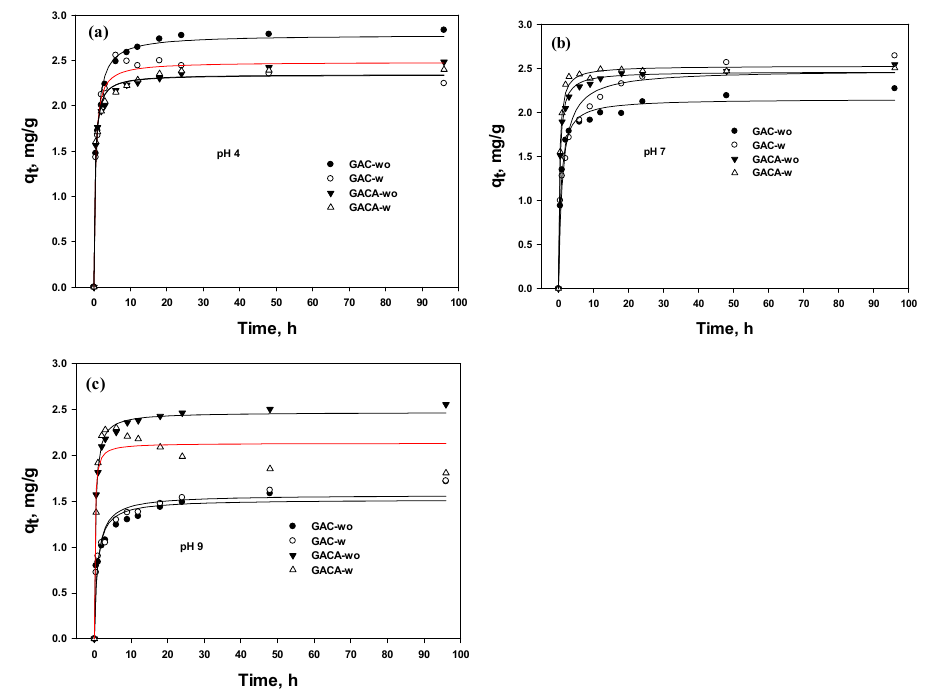
Figure 8. Nonlinear pseudo-second-order (PSO) kinetic for GAC and GACA at initial pH of 4 ( a ), 7 ( b ), and 9 ( c ) (red lines indicate the phosphate desorption experiment). Table 4. Variables of nonlinear PFO and PSO.